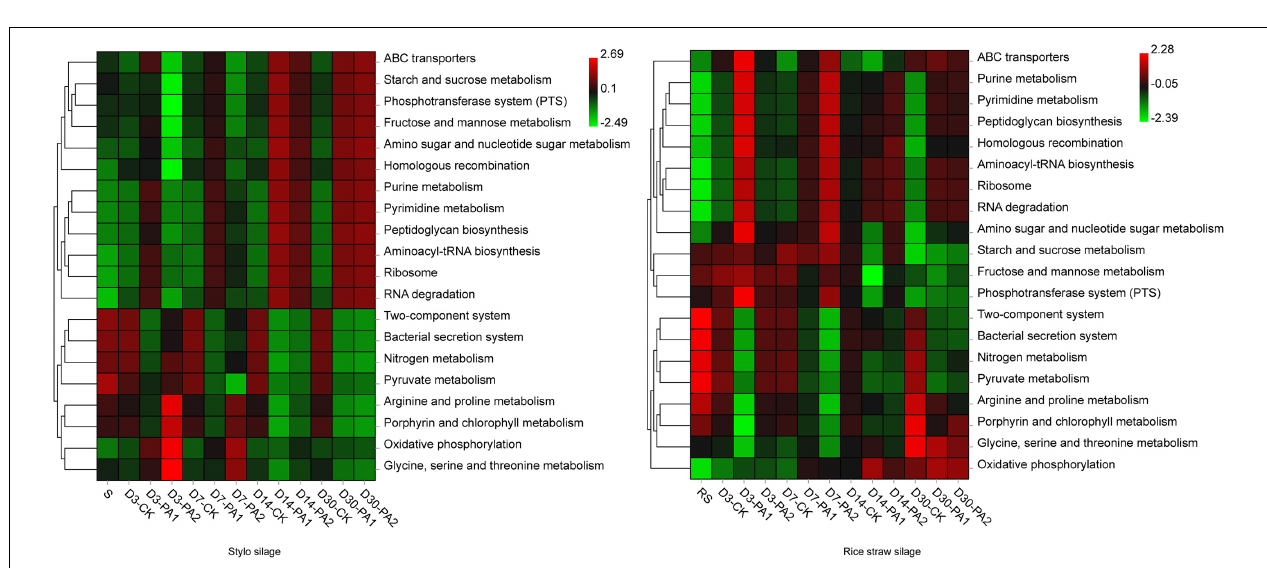
FIGURE 4 | Heatmap of 16S rRNA gene-predicted functional profiles of the microbial communities in stylo and rice straw before and after ensiling for 3, 7, 14, and 30 days with or without 1% or 2% pyroligneous acid.